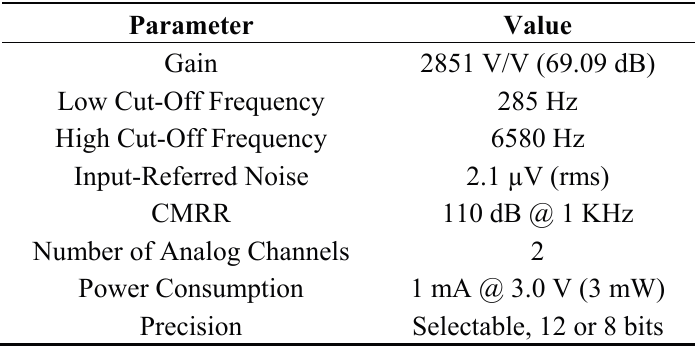
Table 1. Summary of Measured analog front end (AFE) Characteristics.